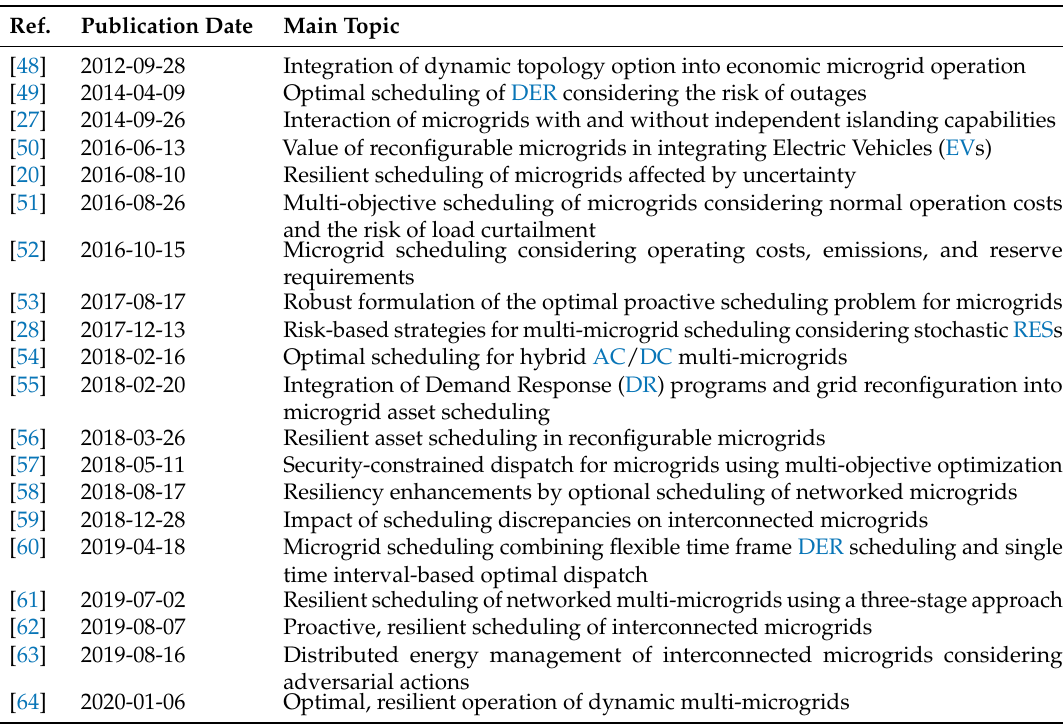
Table 2. Selected key